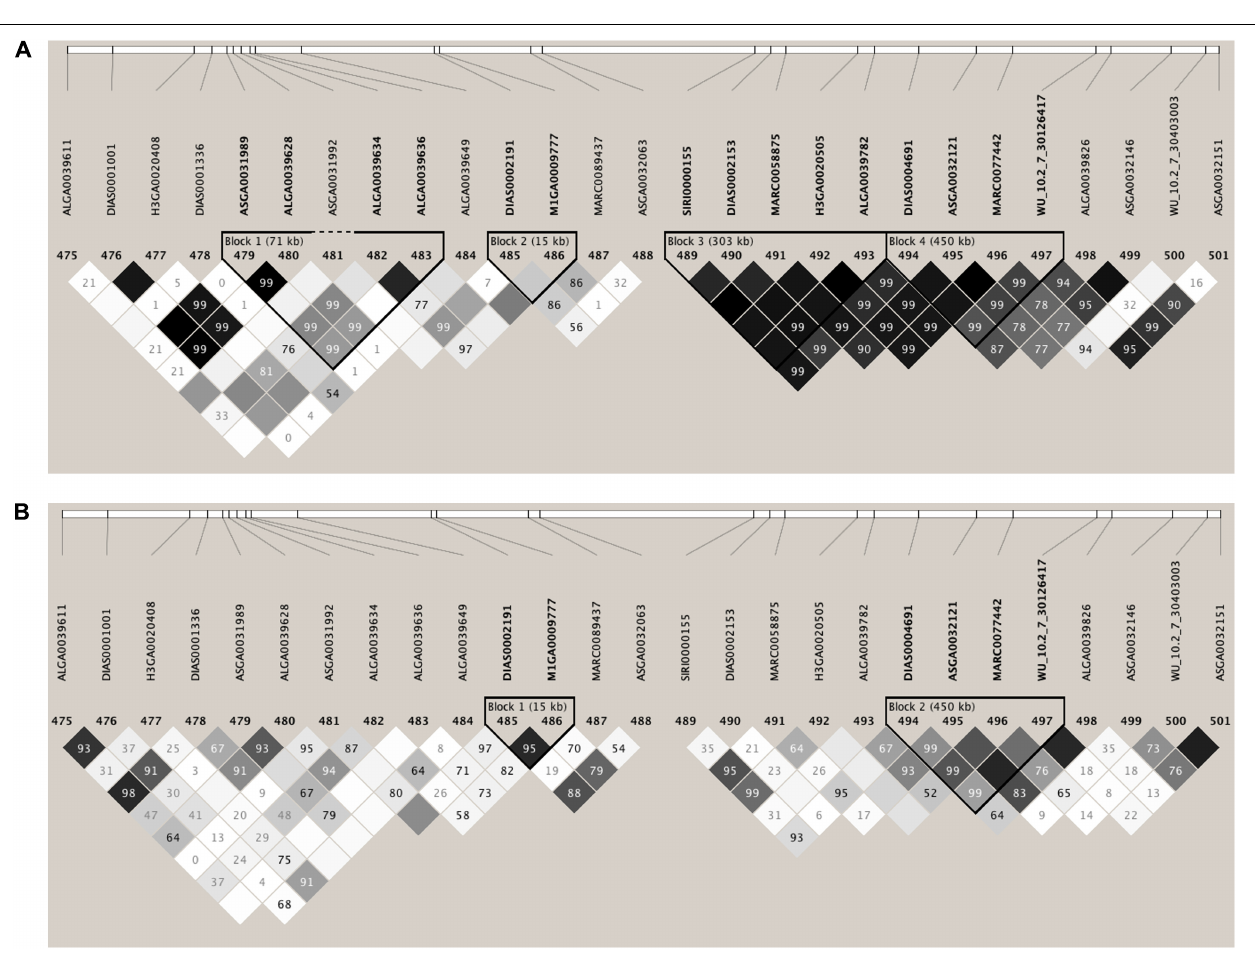
FIGURE 2 | Linkage disequilibrium (LD) plots of the genotype data for the 3-Mb SNP window that harbors the major histocompatibility complex (MHC) on Sus Scrofa chromosome 7 (SSC 7: 24–25 Mb) associated with sample-to-positive (S/P) ratio. (A,B) Results for Duroc and Landrace sows, respectively. LD is expressed as r 2 . The darker diamonds indicate greater LD. These plots indicate lower LD in Landrace sows than Duroc sows within this